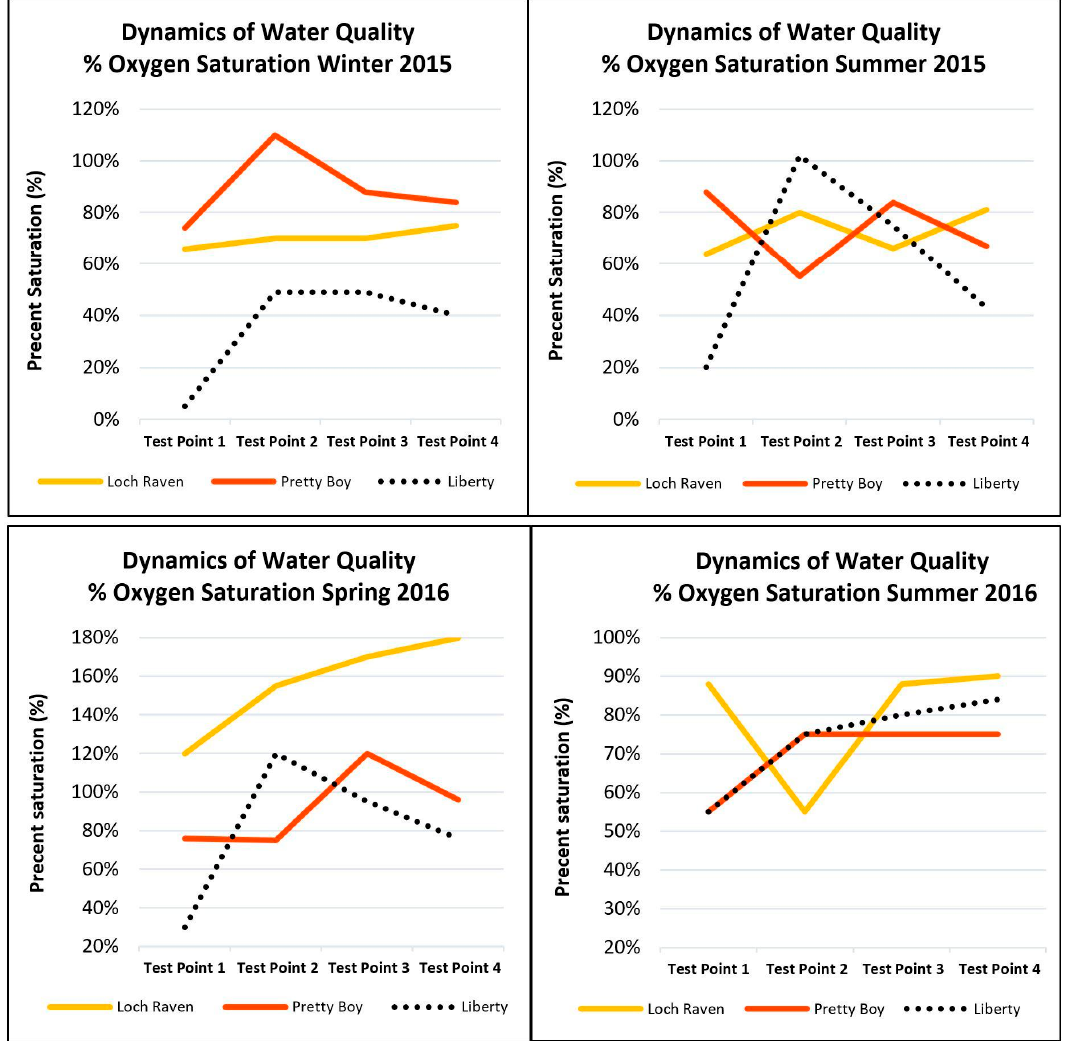
Figure 6. Dynamics of percentage oxygen saturation levels in Liberty, Loch Raven and Prettyboy watersheds during 2015–2016.